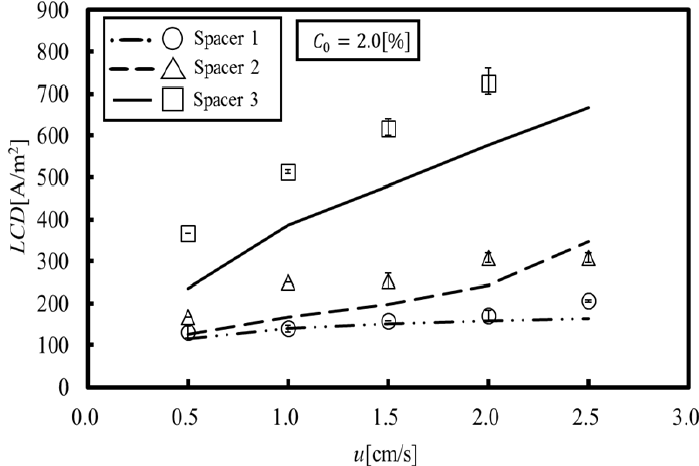
Figure 7. Limiting current density (numerical simulation and experiment [15]). The LCD obtained by our simulation reproduces the experimental results for Spacers 1 and 2. A comparison between LCD and the minimum e ff ective Sherwood number shows correlations between them.